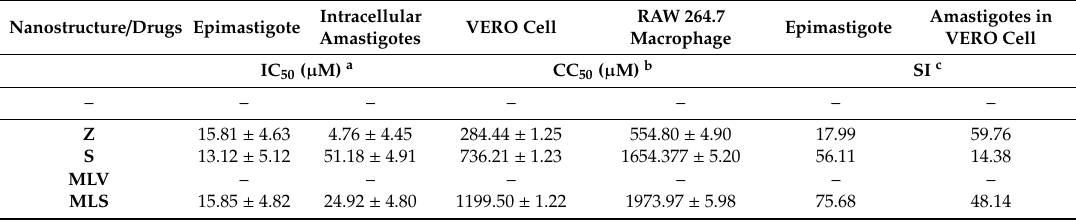
Antiparasitic, cytotoxic activity and selectivity index of BZ, S, MLV, and MLS on Trypanosoma cruzi and on mammalian cells,